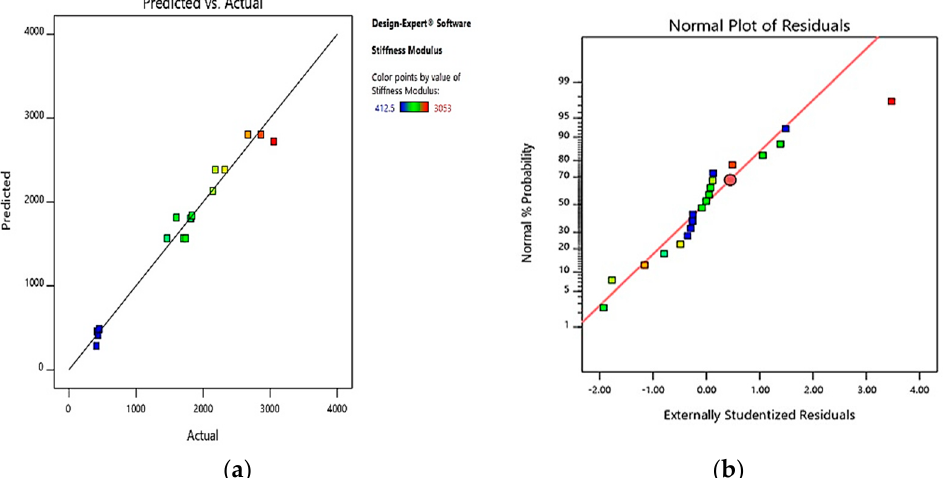
Figure 9. Stiffness modulus response plots for ( a ) predicted against actual, ( b ) normal plot of residuals.